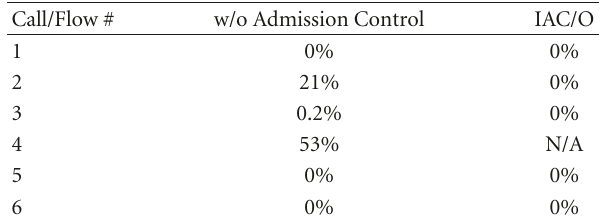
Table 2: Packet Loss Rate (%) for each flow.